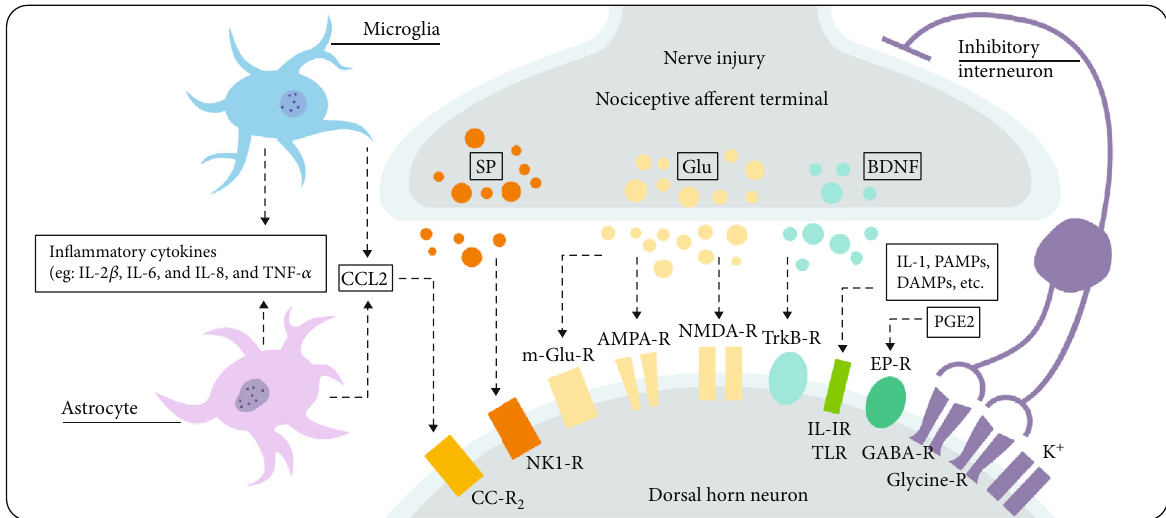
Figure 2: Diagram showing the synaptic junction in the dorsal horn of the spinal cord. Reprinted with permission from Cohen and Mao [54]. Copyright © 2020, British Medical Journal Publishing Group. AMPA= α -amino-3-hydroxy-5-methyl-4-isoxazolepropionic acid; BDNF =brain-derived neurotrophic factor; CCL=chemokine (C-C motif) ligand; CC-R2 =CC-chemokine receptor; DAMPs =danger- associated molecular patterns; EPR=prostaglandin E2 sensitive receptor; GABA = γ -aminobutyric acid; Glu=glutamate; IL =interleukin; m-Glu=metabotropic glutamate; NK =neurokinin; NMDA=N-methyl-D-aspartate; PAMPs=pathogen-associated molecular patterns; PG=prostaglandin; -R=receptor; SP =substance P; TLR =toll-like receptor; TNF =tumor necrosis factor; Trk=tyrosine